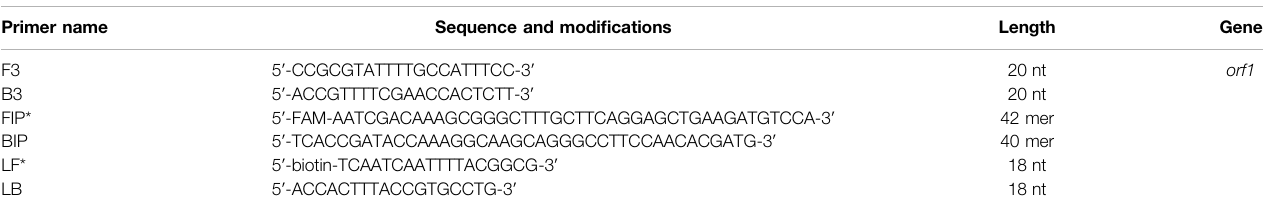
TABLE 1 | N. gonorrhoeae -LAMP primers used in the present